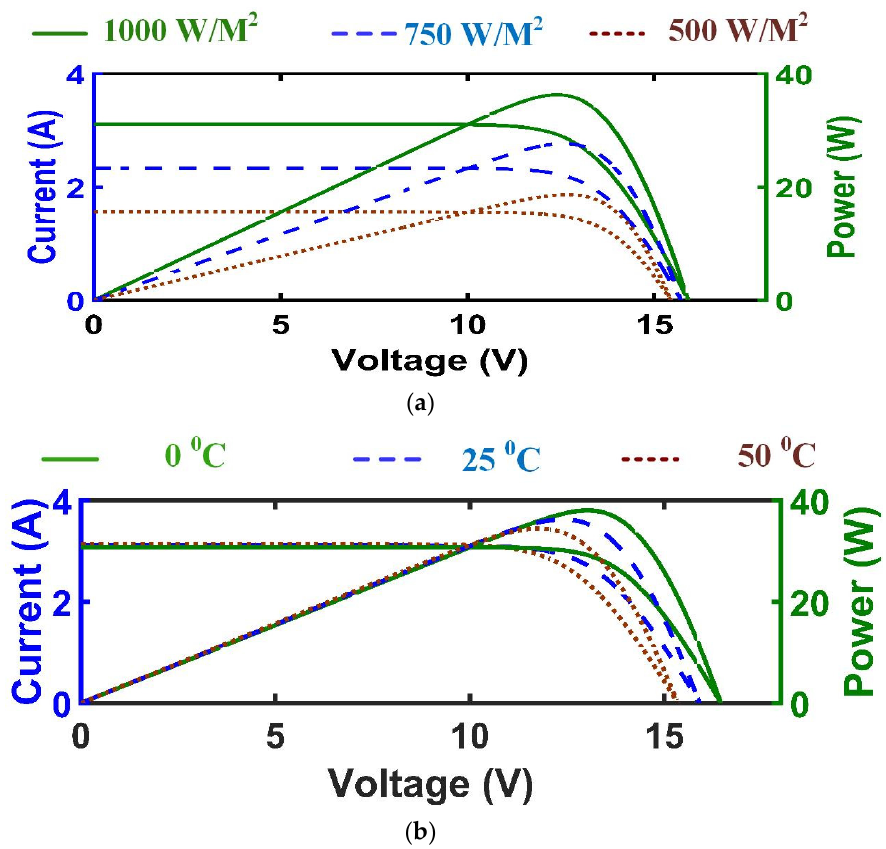
Figure 4. Solar PV Characteristics for ( a ) different values of irradiances and ( b ) different values of temperature.